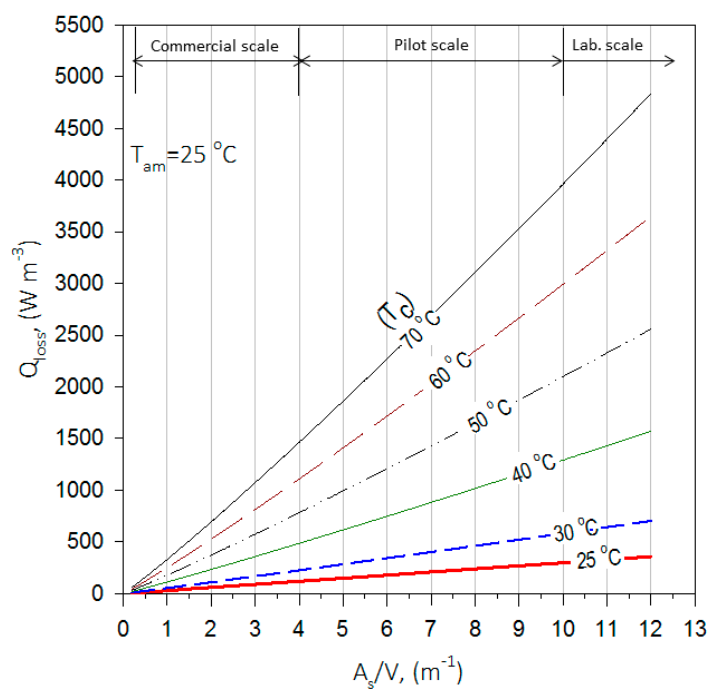
Figure 3. Heat loss per unit volume from a non-insulated steel bioreactor (3 mm wall thickness) as affected by the ratio of surface area to volume ( A s / V ), estimated at different compost temperatures ( T c ).